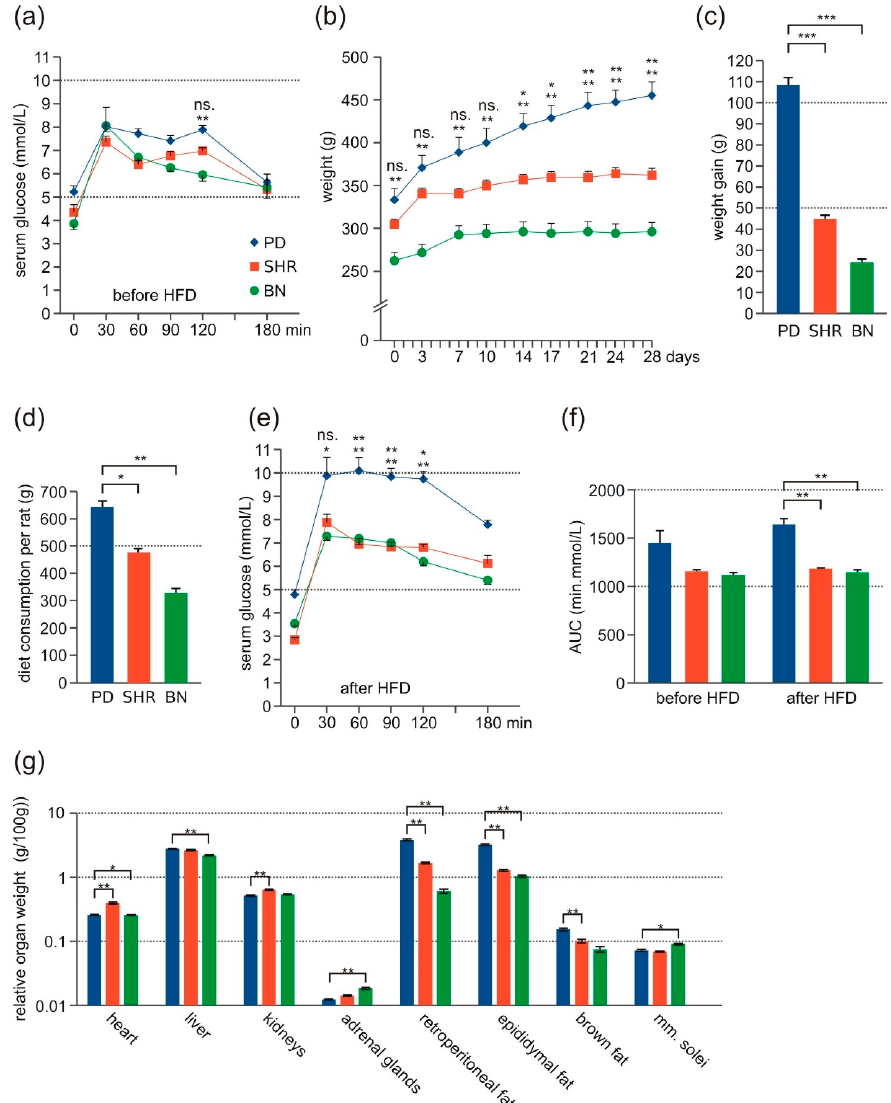
Figure 1. Glucose tolerance and morphometric profile of adult male rats-PD (blue, n = 7), SHR (red, n = 6), and BN (green, n = 7–8). ( a ) Oral glucose tolerance test (OGTT)-time course of glucose level before HFD. ( b ) Time course of body weight during HFD feeding. ( c ) Absolute weight gain during HFD feeding. ( d ) Consumed diet amount per rat of each strain during HFD feeding. ( e ) OGTT-time course of glucose level after HFD. ( f ) The area under the curve (AUC) of OGTT before and after HFD. ( g ) Relative tissue weights per 100 g body weight after HFD. Data are presented as arithmetic means ± SEM. Statistical significance levels for the factor strain of repeated measurements ANOVA (weight, OGTT), one-way ANOVA (weight gain, consumed diet, tissue weight) or two-way ANOVA (AUC) are indicated for pair-wise post hoc Tukey’s test as follows: * p < 0.05, ** p < 0.01, *** p < 0.001. For post-hoc OGTT and weight, the upper symbol corresponds to PD vs. SHR comparison, the bottom symbol represents PD vs. BN comparison, ns. = not